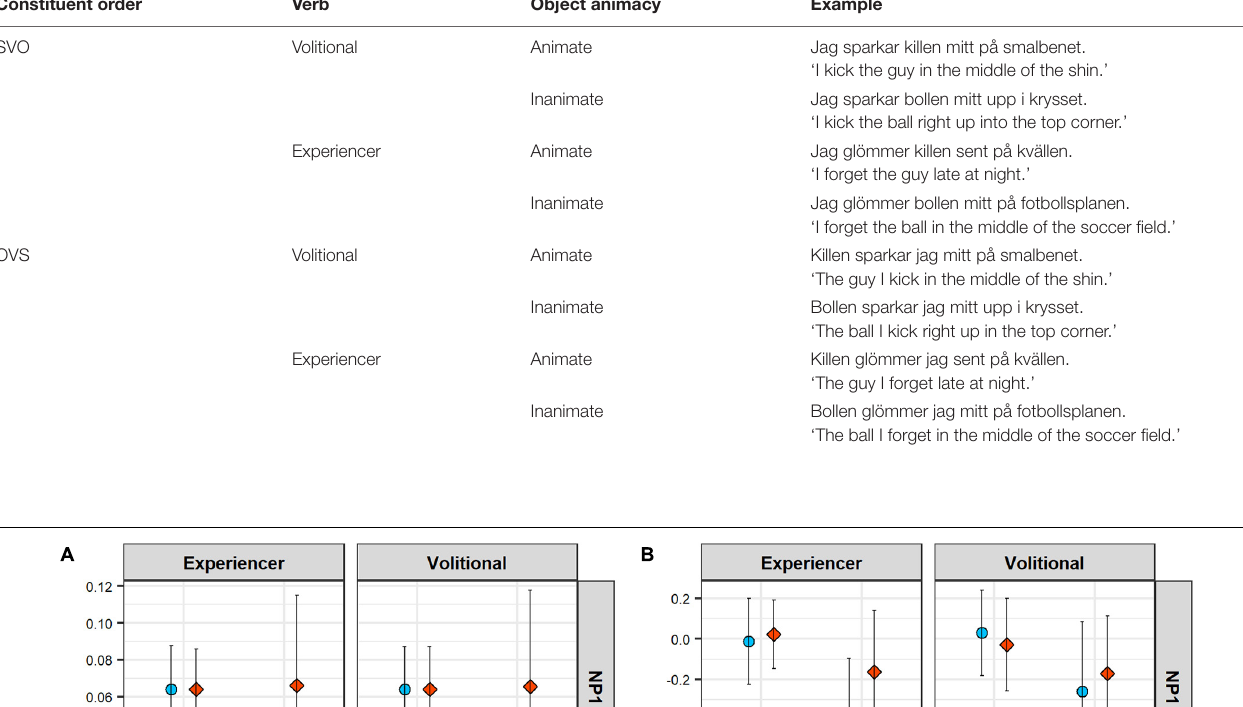
TABLE 2 | Example sentence stimuli of the critical sentences used in the self-paced reading experiment. Constituent order